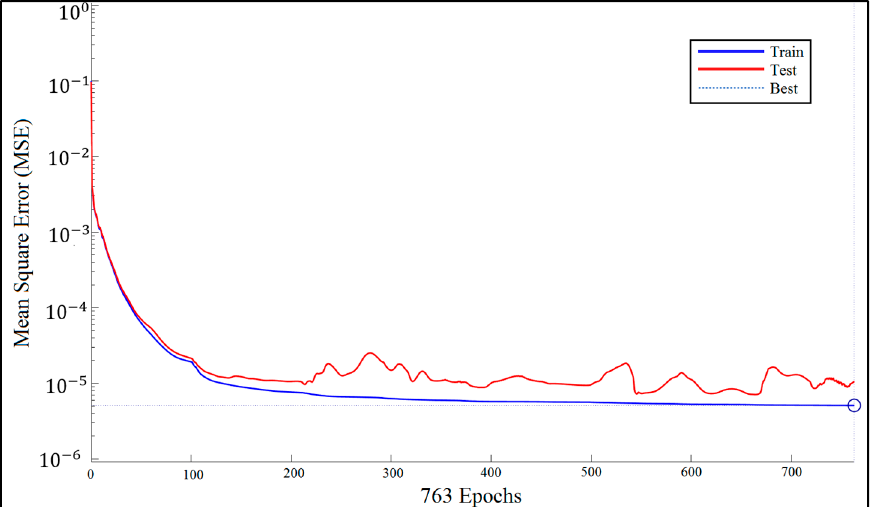
Figure 9. Bayesian regularized neural network (BRNN) performance.